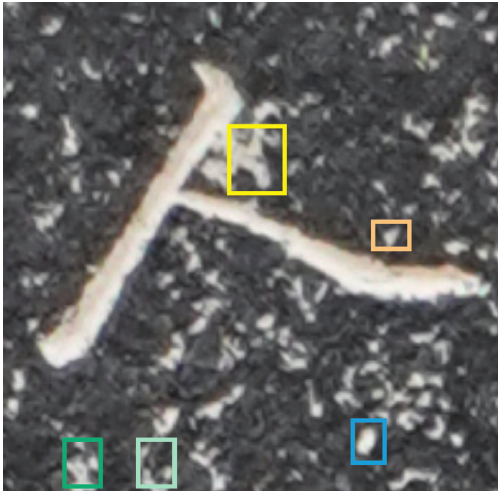
Figure 4: The noise in a stone inscription